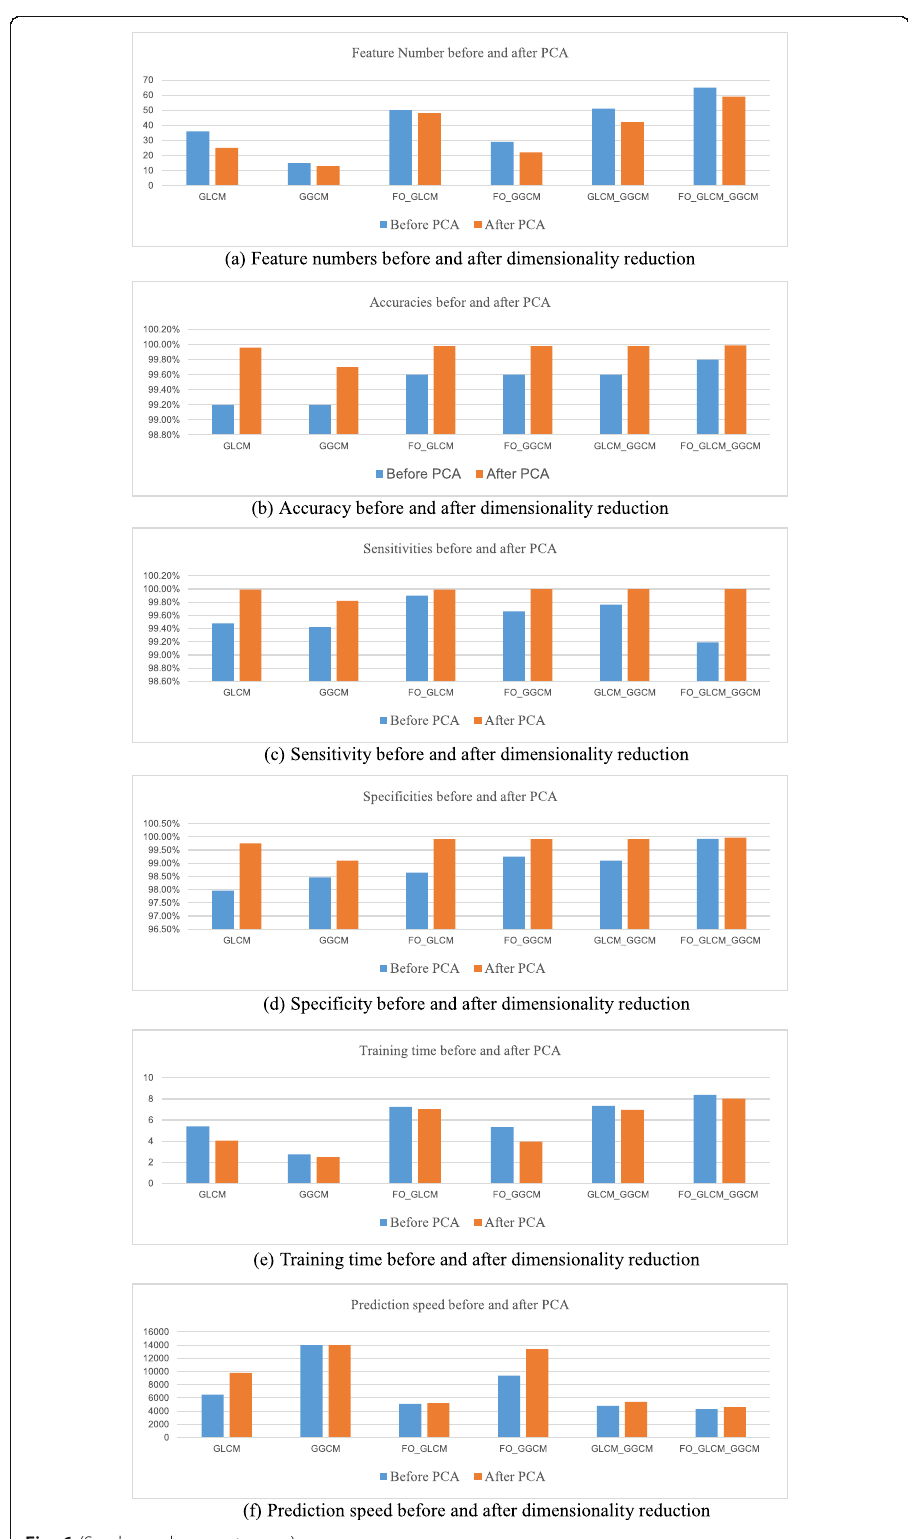
Fig. 6 (See legend on next